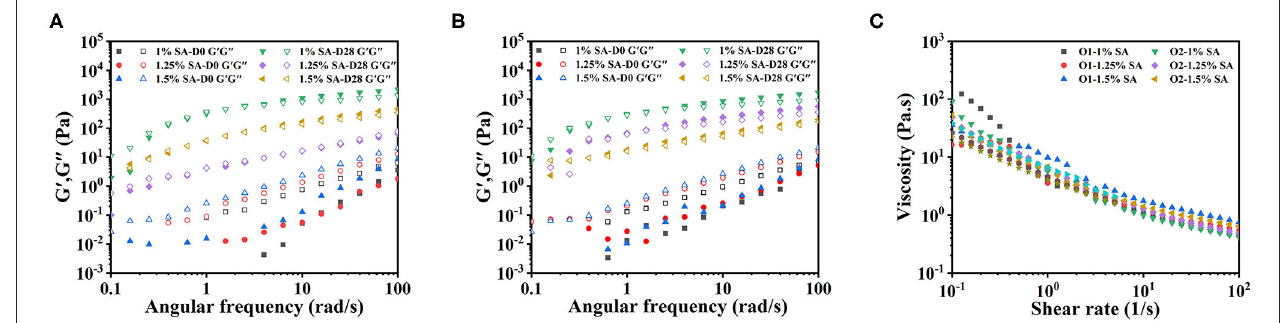
FIGURE 8 | Rheological properties of O1 and O2 emulsions: dynamic frequency sweep images of O1 (A) and O2 (B) emulsions. and steady-state shear sweep images of the emulsions stored for 28 (C) days. D0 and D28 represent emulsions stored for 0 and 28 days.